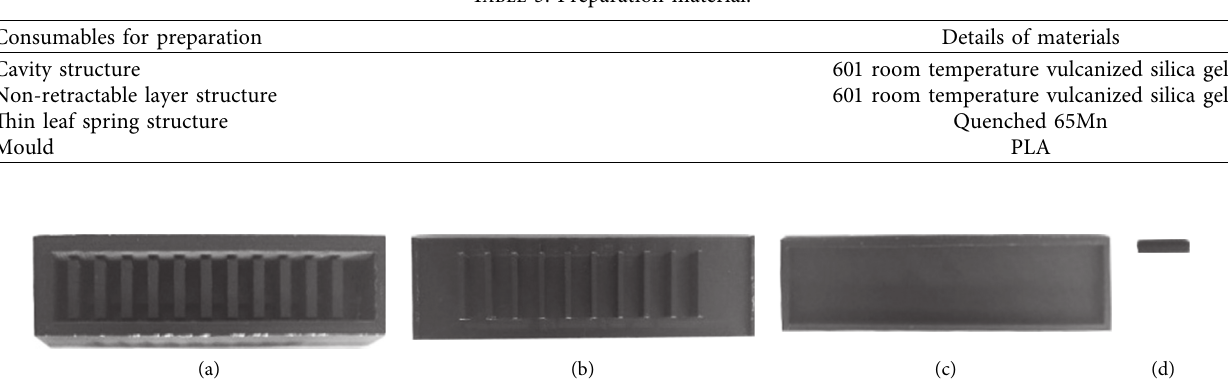
Table 5: Preparation material.